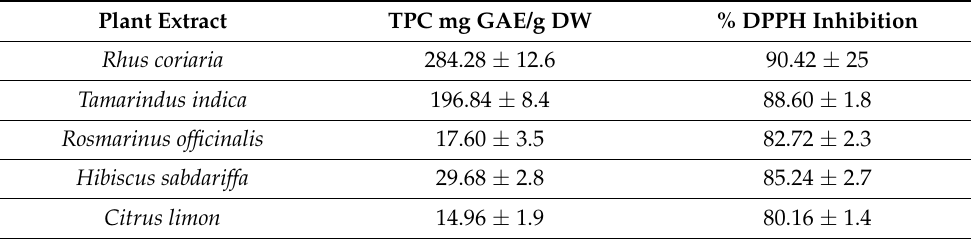
Table 2. Total phenol content (TPC) and % DPPH inhibition of plant